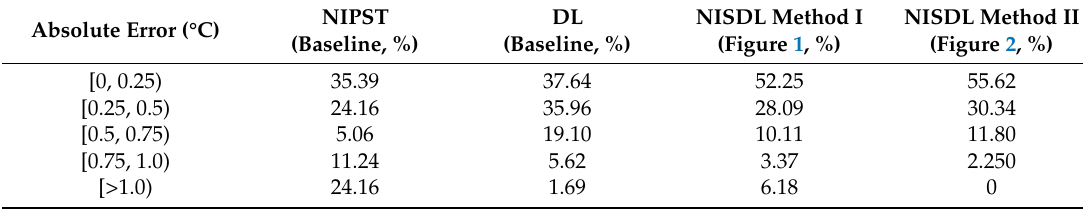
Table 2. Absolute error distribution.